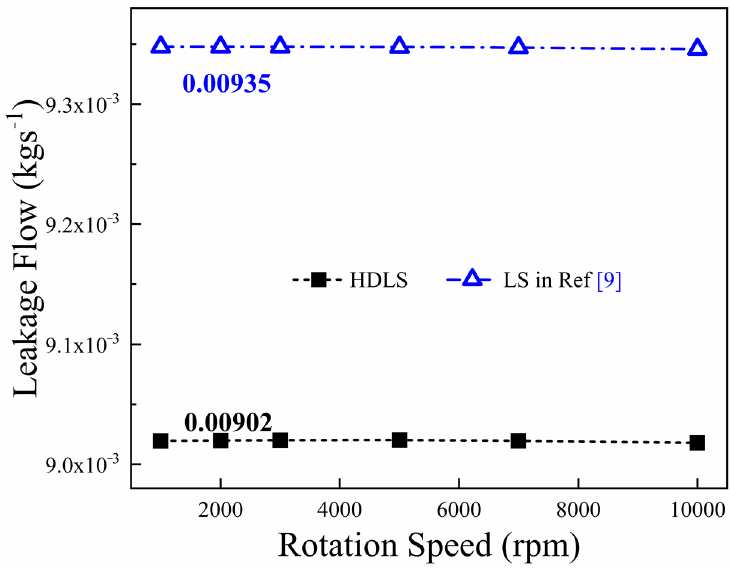
Figure 20. Comparison of leakage performance at a 50 Hz whirl frequency between HDLS and traditional LS in Ref [9].